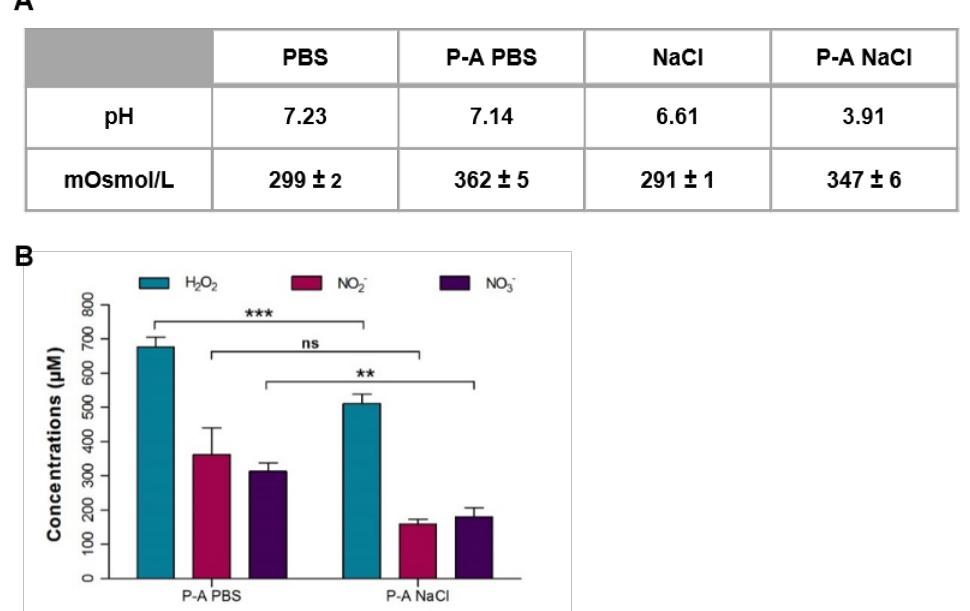
Figure 4. Results of the physicochemical properties analysis in plasma-activated PBS (P-A PBS) and plasma-activated NaCl (P-A NaCl). ( A ) pH and osmolarity were measured directly after exposure to the plasma jet for 120 s, as described in the Materials and Methods section I. PBS vs. P-A PBS and NaCl vs. P-A NaCl: paired t -test *** p < 0.001. PA-PBS vs. P-A NaCl: unpaired t-test, ns: non-significant. N = 3 independent experiments. ( B ) Quantification of the hydrogen peroxide (H 2 O 2 ), nitrite (NO 2 − ) and nitrate (NO 3 − ) in P-A PBS and P-A NaCl. Unpaired t-test *** p < 0,001, ** p < 0.01; ns: non-significant p > 0.05. N = 4 independent experiments.